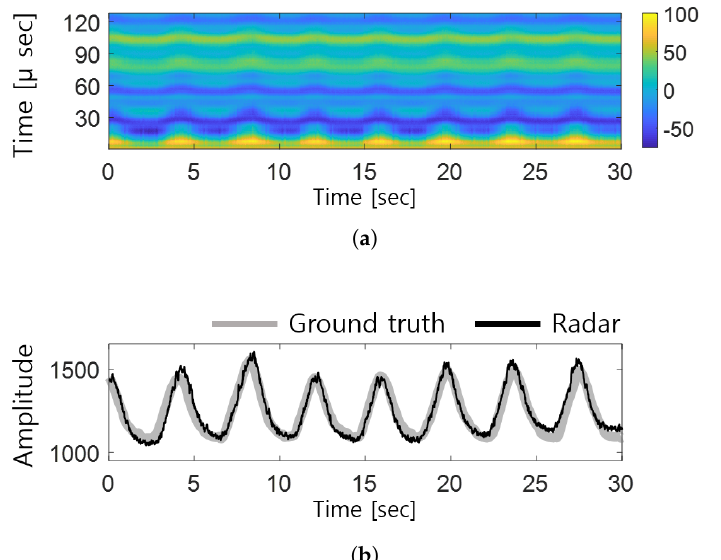
Figure 1. Comparison of breathing signals. ( a ) Intermediate frequency signals of the radar. ( b ) Com- parison of respiratory signals acquired with the radar and breathing